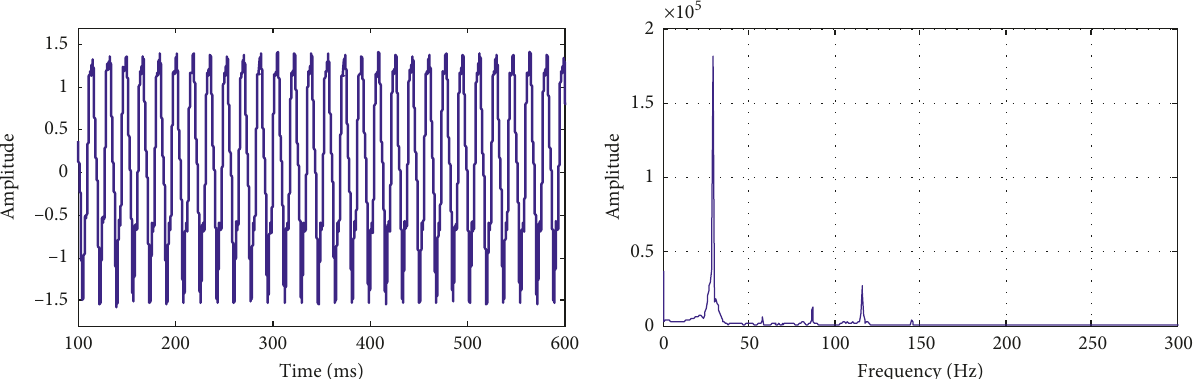
Figure 9: Vertical vibration amplitude signals and its frequency diagram on the disk.